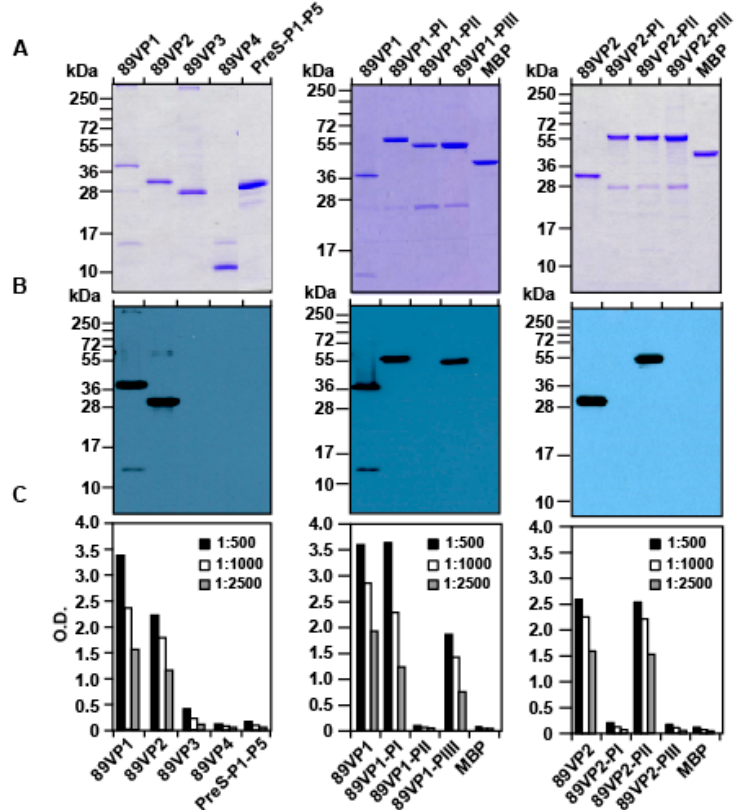
Figure 3. Reactivity of anti-RV89 guinea pig IgG antibodies to recombinant RV89-derived capsid proteins and fragments thereof. ( A ) Coomassie blue-stained SDS-PAGE containing purified viral capsid proteins: 89VP1-89VP4 ( left panel); VP1 and VP1 fragments: 89VP1-PI-PIII ( middle panel); and VP2 and VP2 fragments: 89VP2-PI-PIII ( right panel). PreS-P1-P5 and MBP represent negative control proteins. Molecular weights in kDa are indicated on the left margins. ( B ) IgG reactivity of the anti-RV89 guinea pig antibodies to nitrocellulose-blotted proteins from A. ( C ) IgG reactivity of three different dilutions (1:500, 1:1000, and 1:2500) of anti-RV89 guinea pig antibodies to RV antigens ( x -axes) as measured by ELISA. Bound IgG antibodies are expressed as optical density values (OD, y-axes).